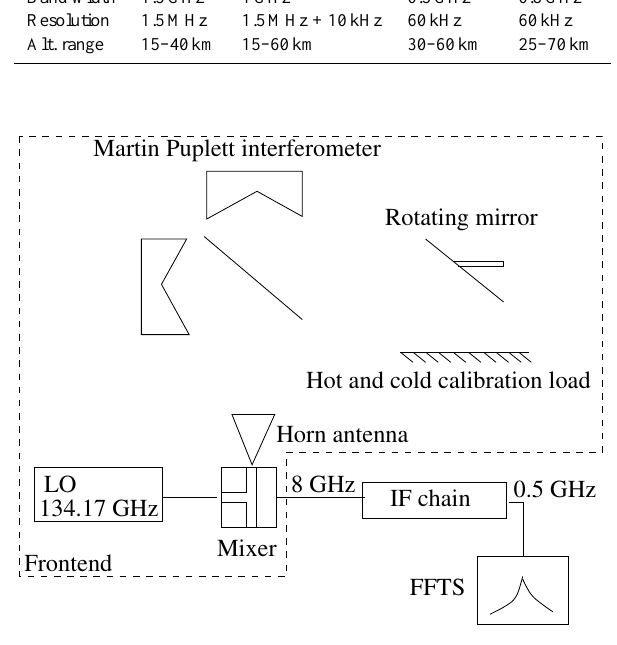
Fig. 1. Overview sketch of the OZORAM. Technical details are described in Klein (1993) and have been omitted for clarity. The dashed line encloses the front end with the quasi optical system and the first mixing